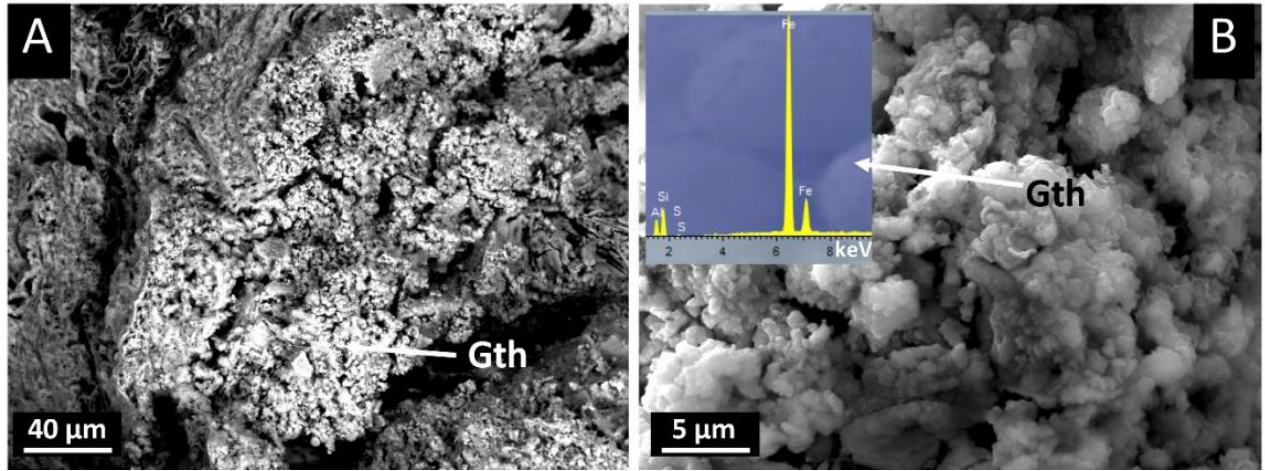
Figure 5. FESEM and EDX images of goethite from periodically emerged sediments of La Playa dam (( A ) sample LP8, ( B ) sample LP9). Gth: goethite.